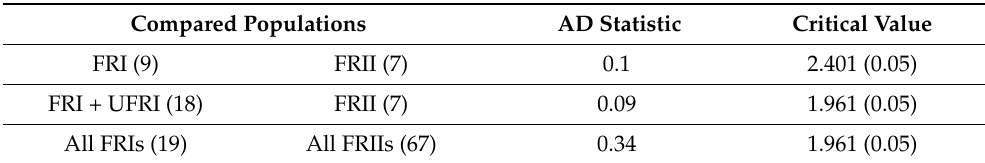
Table 4. Results of the Anderson-Darling test that has been used to assess the Eddington ratios of FRI and FRII quasars.